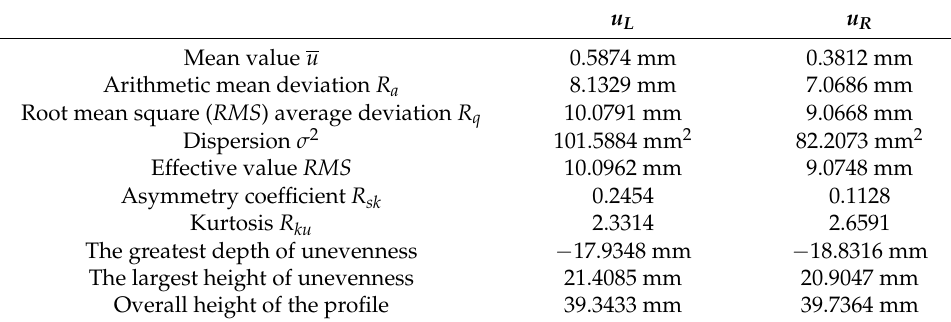
Table 1. Statistical characteristics of the road profiles.